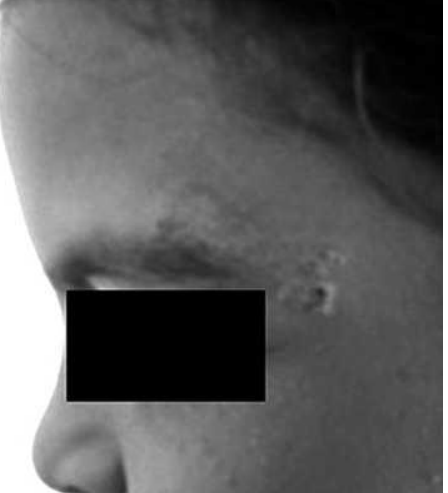
Fig. 5 – Dry face lesion due to L. killicki (Focus of